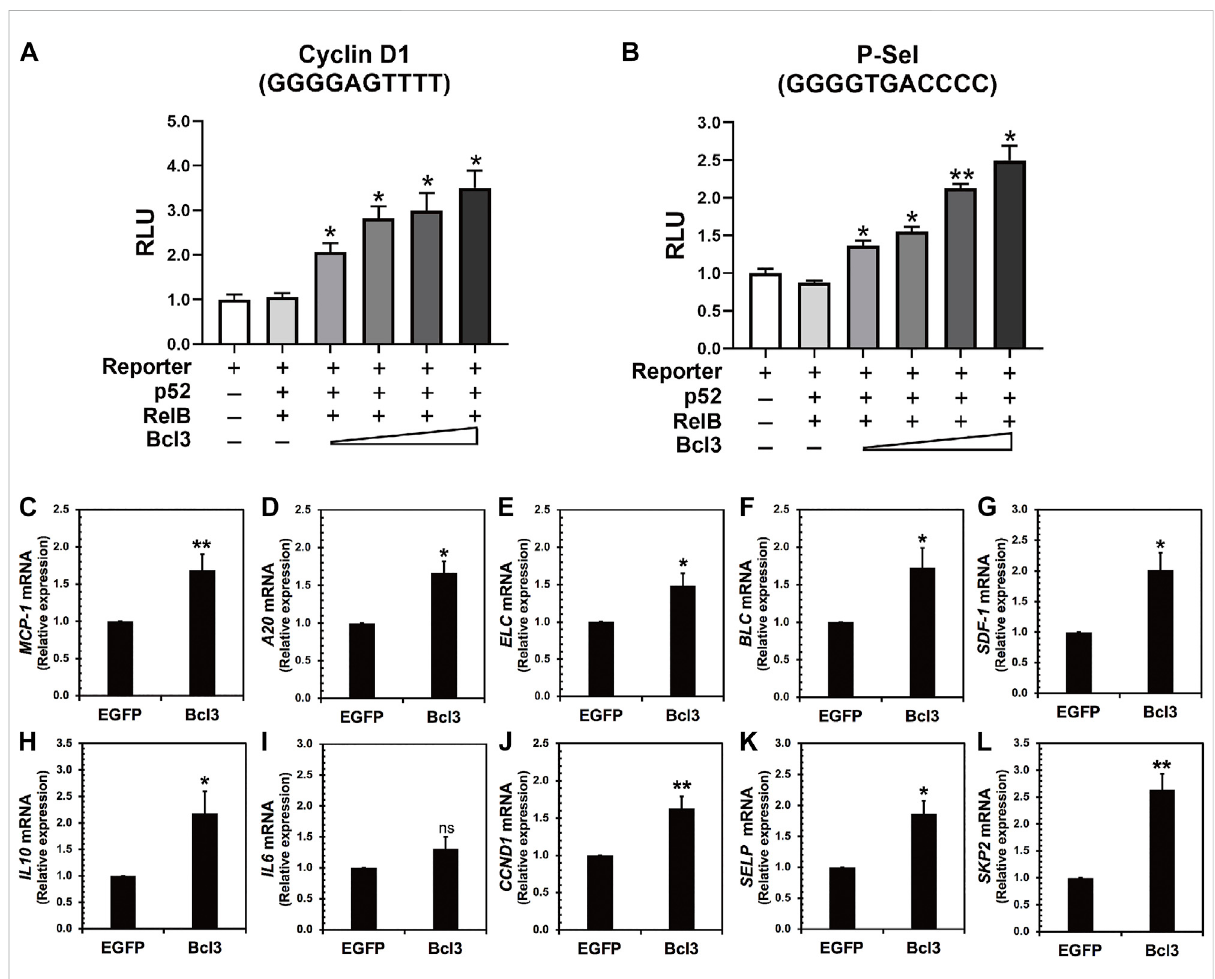
FIGURE 6 Bcl3 increases the expression of p52:p52 homodimer target genes. (A) P-selectin and (B) cyclin D1 luciferase reporter activities were increased withincreasingBcl3co-expression. Thereporter plasmidencodingtheP-selectin orcyclinD1 κ Bsitewasco-transfectedwith aconstantamount of p52, RelB, and an increasing amount of Bcl3 into HeLa cells. The data were analyzed from three independent experiments performed in triplicate. RLU, relative luciferase unit. * p < 0.05 and ** p < 0.01 versus reporter only control ( t test). Error bars represent SD. (C – L) Relative mRNA levels showing (C) MCP-1 , (D) A20 , (E) ELC , (F) BLC , (G) SDF-1 , (H) IL10 , (I) IL6 , (J) CCND1 , (K) SELP, and (L) SKP2 were upregulated upon Bcl3 overexpression in A2780 cells by RT-qPCR analysis. * p < 0.05, ** p < 0.01, n. s., not signi fi cant versus pLV-EGFP infection control ( t test). Error bars represent